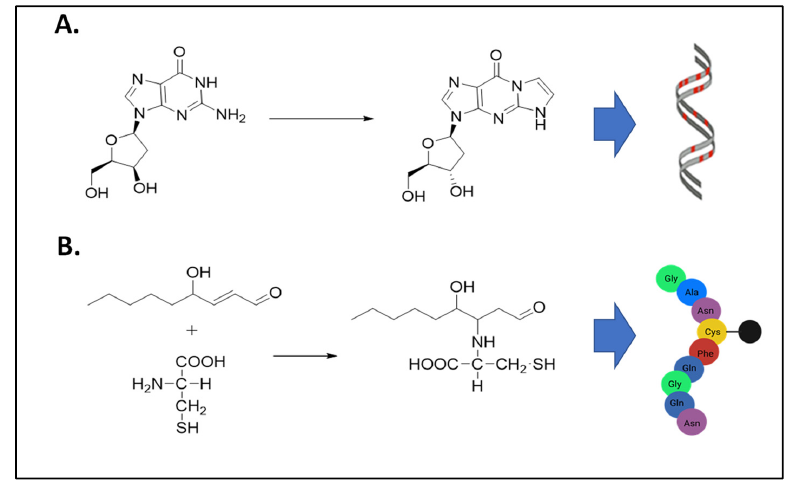
Figure 1. Exogenous and endogenous aldehydes cause DNA and protein adduct formations. ( A ) Formation of N 2 -etheno-2 ′ -deoxyguanosine DNA adduct from deoxyguanosine and α , β -unsatu- rated aldehydes as products of lipid peroxidation. ( B ) Formation of a 4-hydroxynonenal (4-HNE) protein adduct from the reaction between 4-HNE and a cysteine residue. In addition to cysteine adducts, 4-HNE protein adducts can also form on histidine or lysine amino